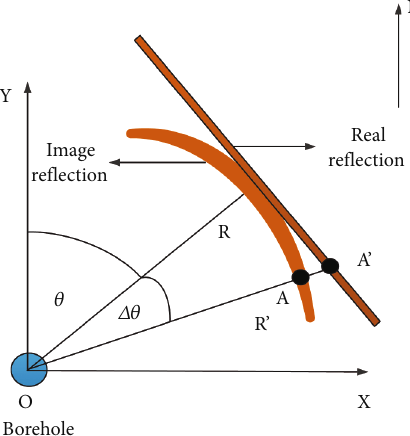
Figure 1: Schematic diagram of curved surface